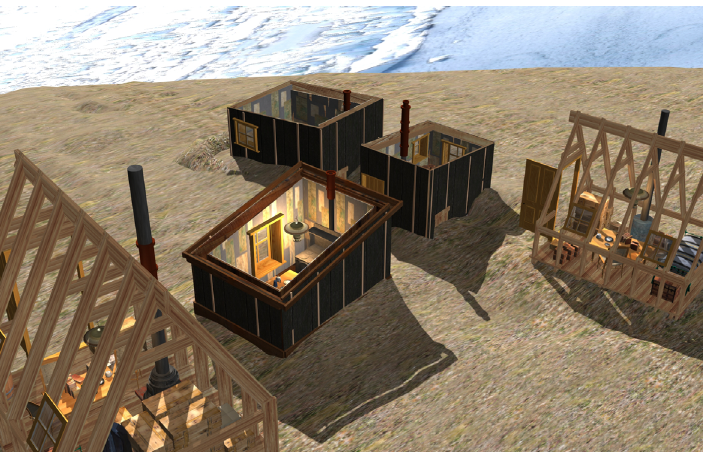
Figure 9. Computer reconstruction of Robert Peary’s hut complex. The roofs have been removed to show interior